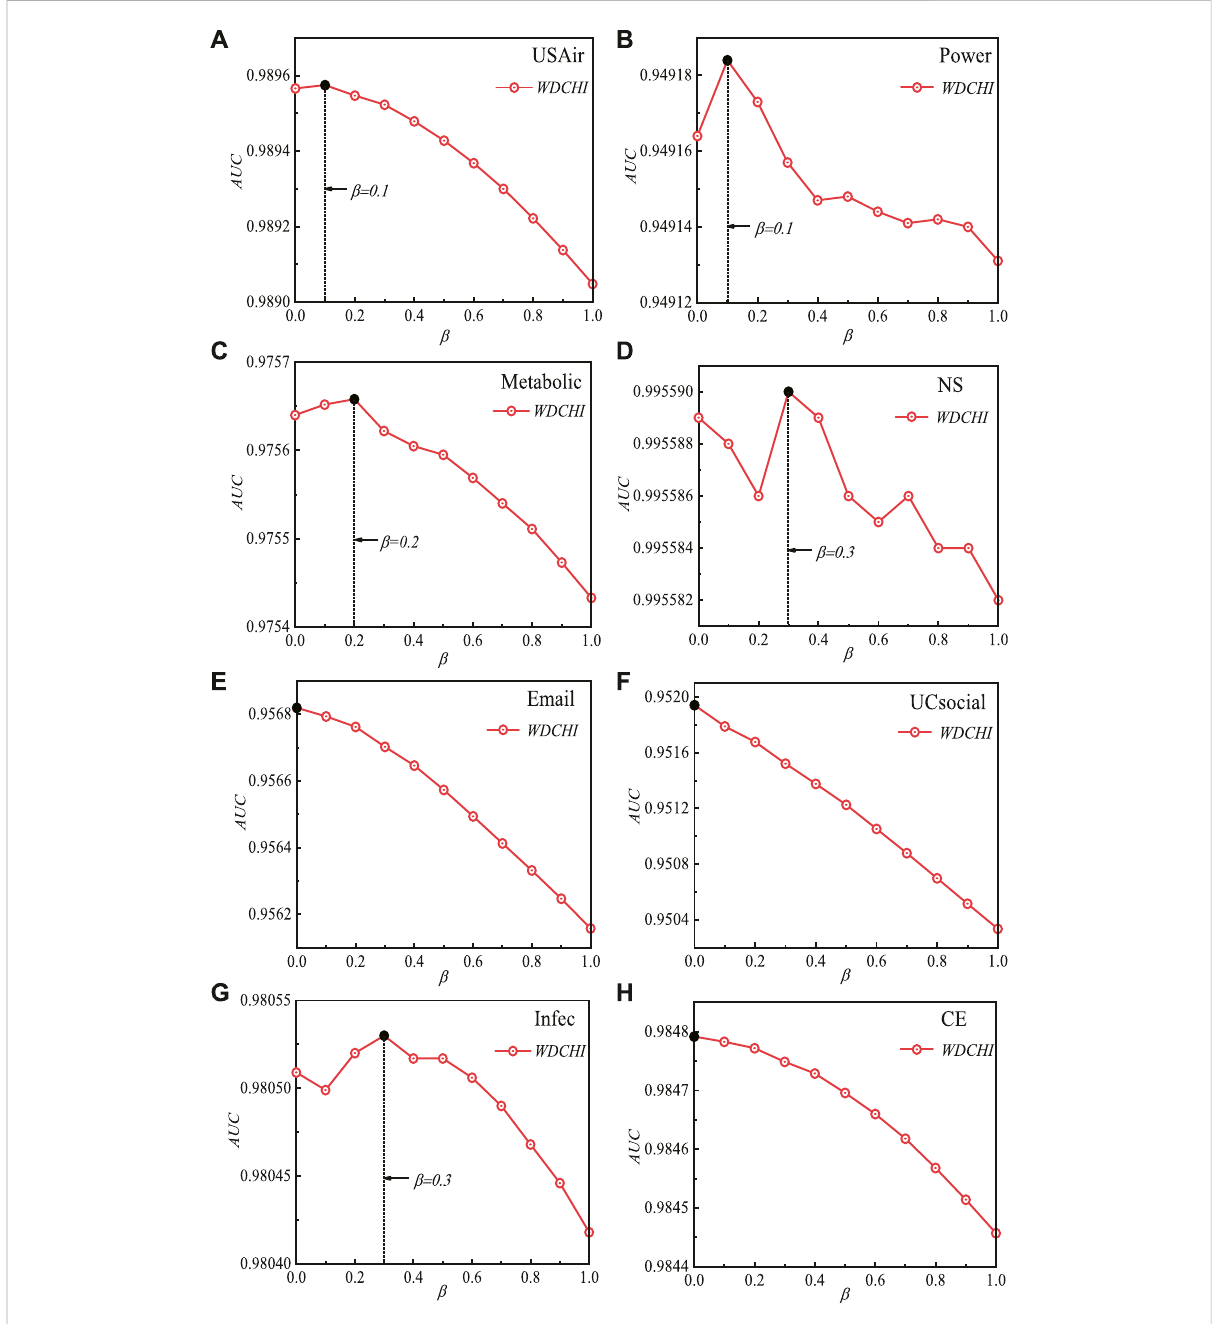
FIGURE 3 (ColorOnline)AUC ’ ssensitivitytothelevelsoftheinhibitoryfactor β withL=100. Inthisstudy,thetraining andtestingsets aredivided 30times in a completely random manner. The average of the 30 runs is the